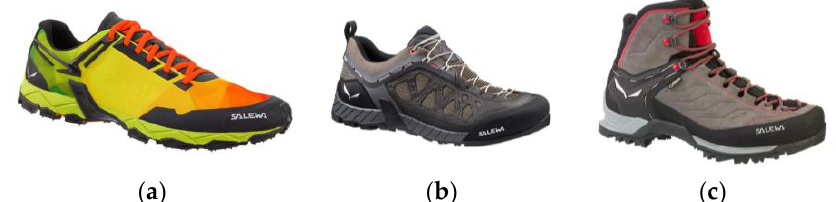
Figure 1. The three types of shoes tested: ( a ) Trail Running (TR); ( b ) Fast Hiking (FH); ( c ) Classic Hiking (CH).